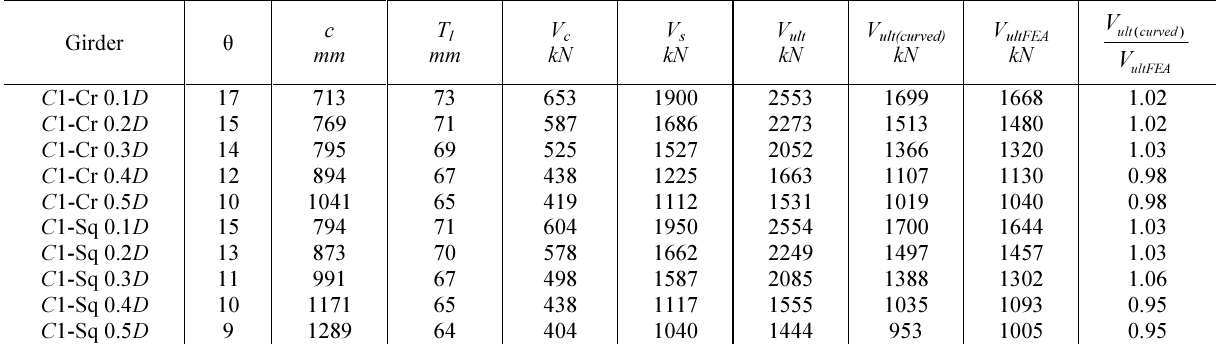
Table 2. Comparison of results for girders with perforated webs Girder